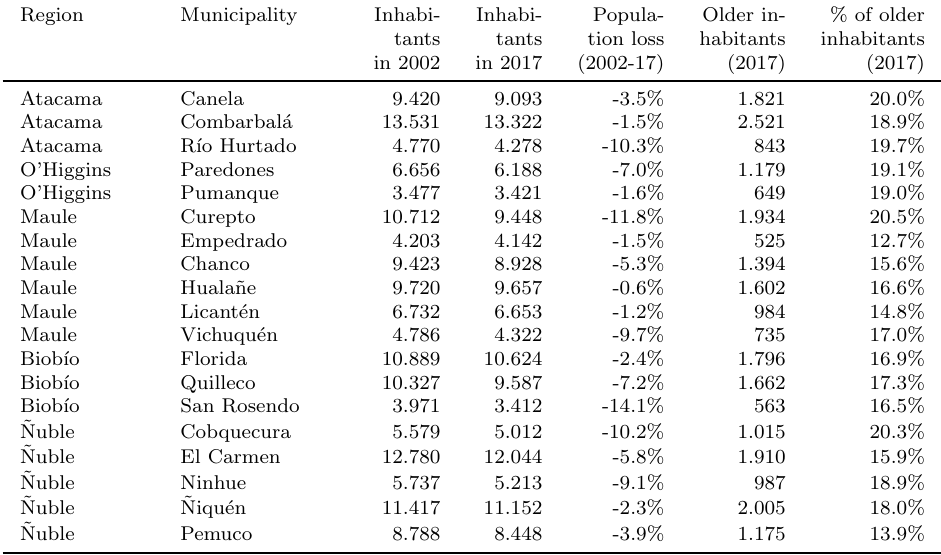
Table 2: Population of the selected ageing municipalities; regions are shown from North to South